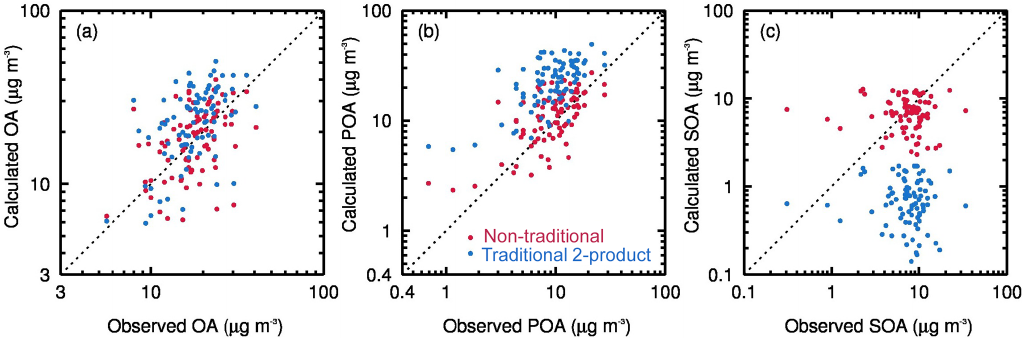
Figure 10. Scatter plots of the simulated (a) OA, (b) POA, and (c) SOA from the traditional (blue spots) and non-traditional (red spots) SOA modules against the observations at 29 sites from 23 to 25 April